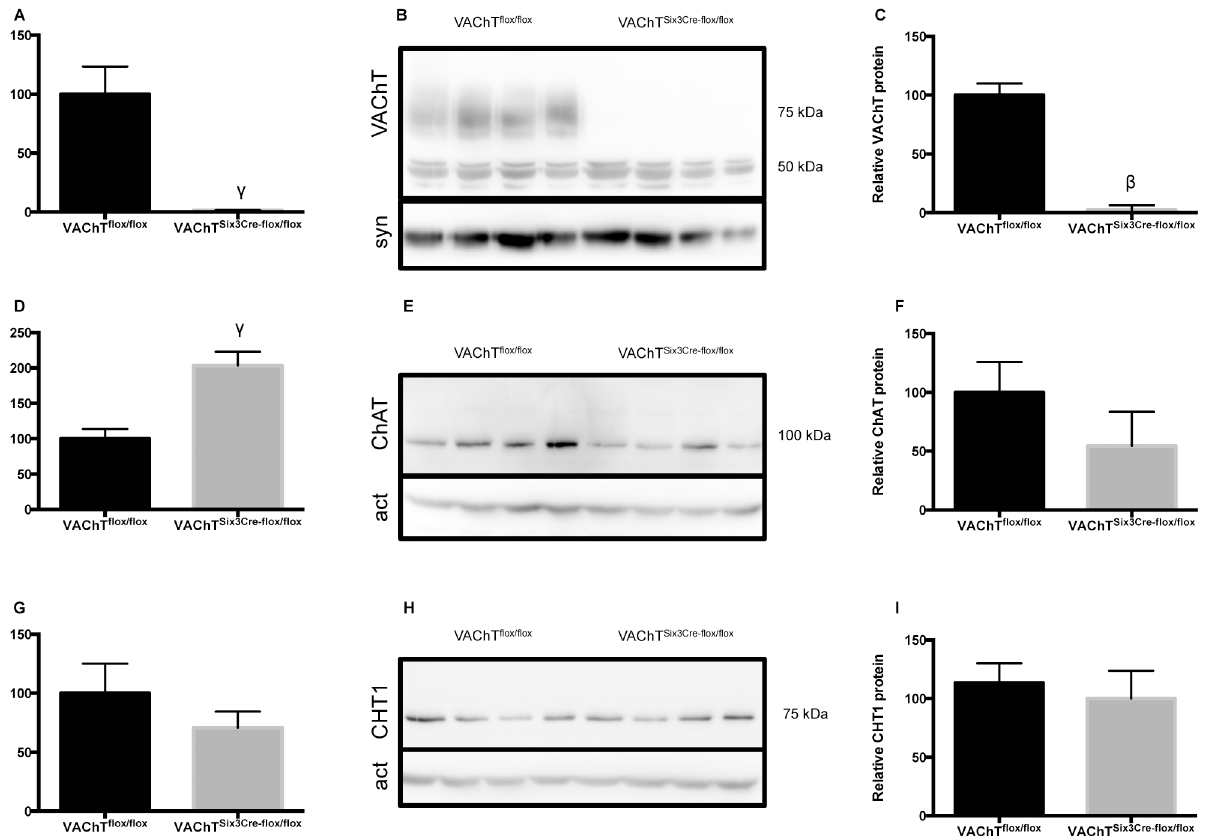
Fig 2. Assessment of gene and protein expression of cholinergic markers. (A, D & G) Quantitative real-time PCR (qRT-PCR) assessed expression levels of VAChT, ChAT and CHT1 mRNA from retinal tissue of VAChT Six3-Cre-flox/flox (n = 5) and littermate control mice (VAChT flox/flox , n = 6). (B, E & H) Immunoblotting followed by (C, F & I) densitometry assessed protein levels of cholinergic proteins (A) Expression of VAChT mRNA in the retina of VAChT Six3-Cre-flox/flox mice is significantly reduced relative to control. Expression of VAChT protein ChAT increased. (B) Immunoblotting. (B, E, H) Expression levels of VAChT, ChAT and CHT1 protein in the retina of VAChT Six3-Cre-flox/flox and littermate control mice were quantified using densitometry. Expression of VAChT protein in the retina of VAChT Six3-Cre-flox/flox mice (n = 5) is reduced relative to littermate control (n = 6) (C). Synaptophysin protein was used as a loading control for VAChT, while actin protein was used for ChAT and CHT1. Values in (A) and (C) represent mean ± SEM, γ , P < 0.01; β , P < 0.001 versus control